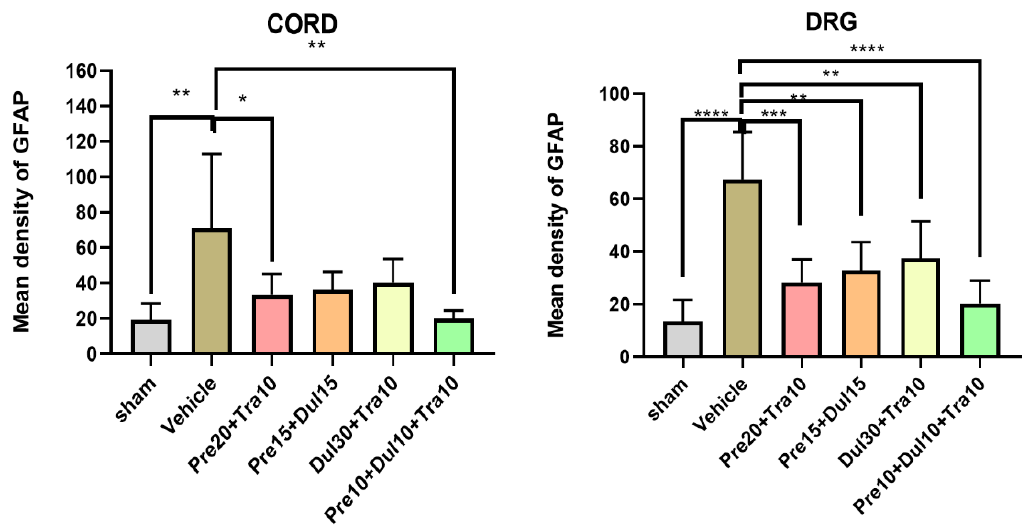
Figure 6. Histogram representing the optical density of GFAP in spinal cord, DRG from sham (n = 4), and normal saline-treated ( n = 4) SNL mice. Pre20 mg/kg + Tra10 mg/kg-treated ( n = 6) SNL mice, Pre15 mg/kg + Dul15 mg/kg-treated ( n = 6) SNL mice, Dul 30 mg/kg + Tra10 mg/kg-treated ( n = 6) SNL mice, Pre10 mg/kg + Dul10 mg/kg + Tra10 mg/kg-treated ( n = 6) SNL mice. The expression of GFAP in the four treated group was significantly decreased compared to the normal saline treated group in DRG. GFAP, glial fibrillary acidic protein; DRG, dorsal root ganglia; Pre, Pregabalin; Dul, Duloxetine; Tra, Tramadol; SNL, spinal nerve ligation. * p < 0.05, ** p < 0.005, *** p < 0.001, **** p < 0.0001.